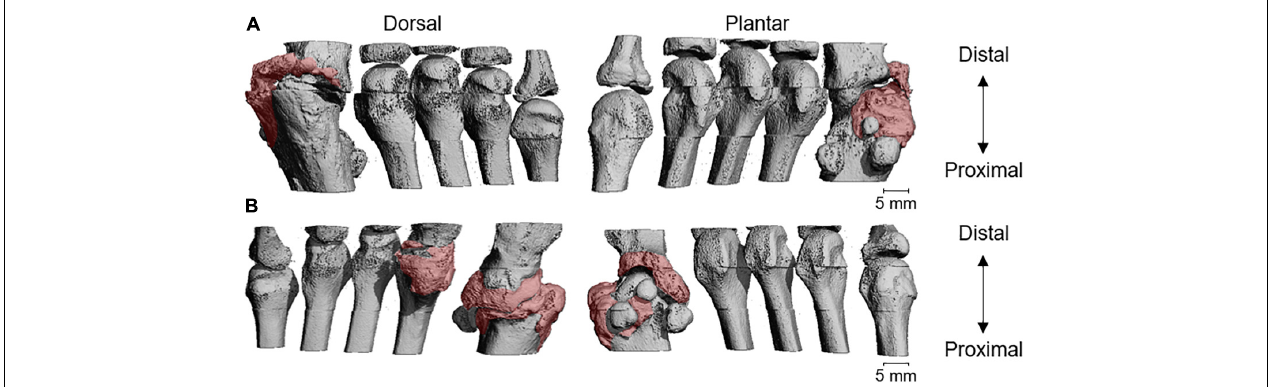
FIGURE 3 | Three-dimensional visualization of the scanned metatarsals of the right (A) and left (B) foot of patient 1. The patient underwent surgery for the correction of a bilateral hallux valgus at the age of 1, resulting in heterotopic ossification (HO) at the operated sites. The pink color visualizes the sites with HO. It should be noted that, due to fusion, the exact border between HO and skeletal bone could not be established.